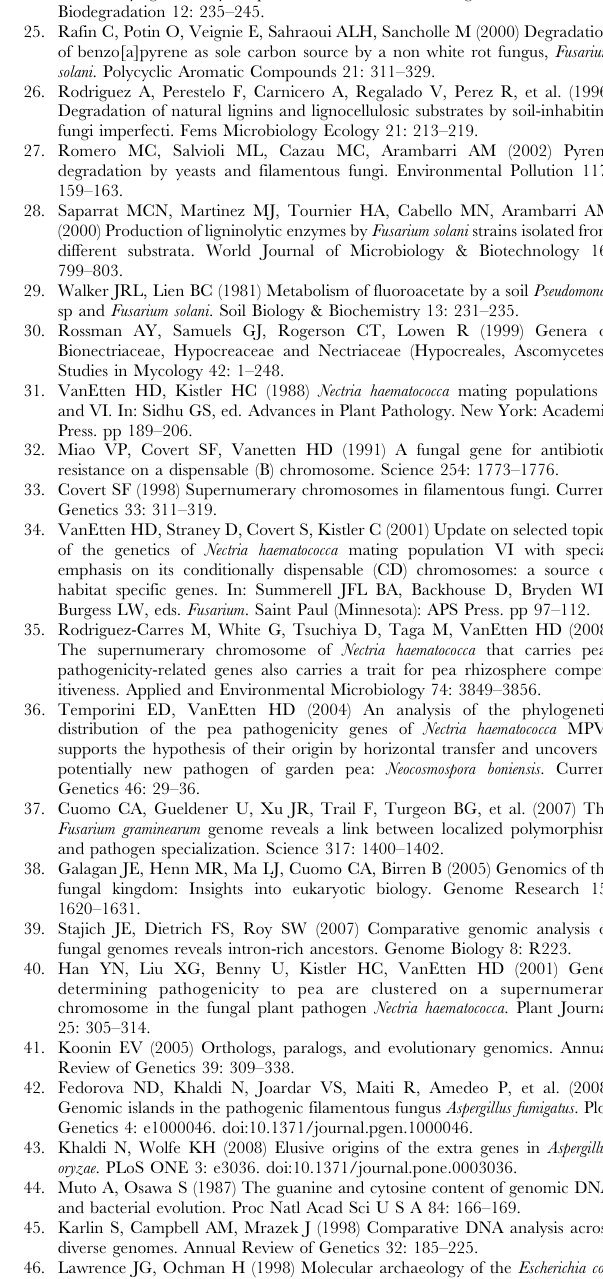
Table S12 The number of polyketide synthases (PKS) and nonribosomal peptide synthetases (NRPS) of Nectria haemato- cocca MPVI compared to other fungi.